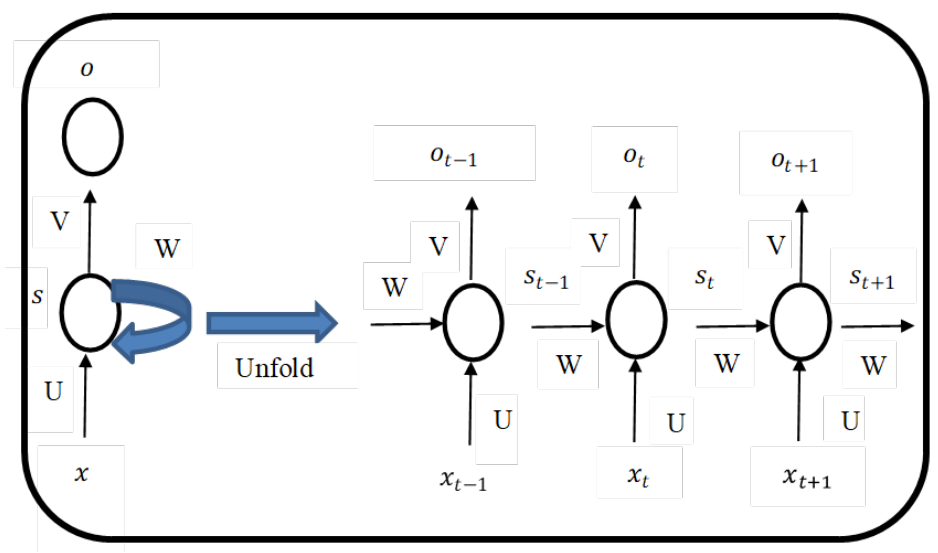
Figure 3. Showing RNN architecture.